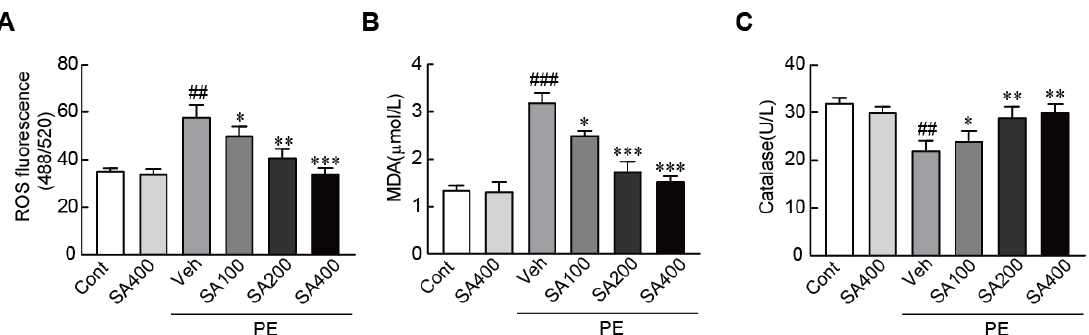
Figure 6. SA inhibits oxidative stress in PE-stimulated hypertrophic cardiomyocytes. ( A ) DCFH-DA dye for ROS production, ( B ) MDA, and ( C ) catalase were measured in cardiomyocytes pretreated with 100, 200, and 400 µ M SA for 24 h, followed by treatment with 100 µ M PE. Data are expressed as the mean ± standard error of the mean (SEM). Significance was assessed by one-way analysis of variance (ANOVA) with a Bonferroni post hoc test. ## P < 0.01 and ### P < 0.001 vs. the control group; * P < 0.05, ** P < 0.01, and *** P < 0.001 vs. the PE-only treated group. Veh, vehicle-treated; SA100, SA200, and SA400, 100, 200, and 400 µ M SA-treated groups, respectively; MDA, malondialdehyde; PE, phenylephrine; Cont, control; SA, sinapic acid.